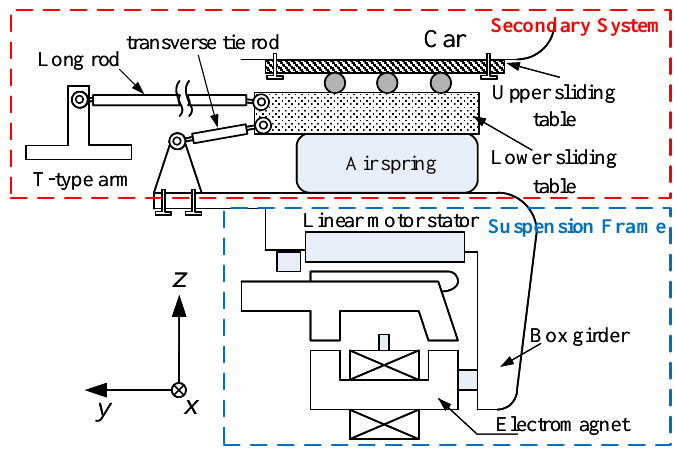
Figure 2. One side of secondary system structure.